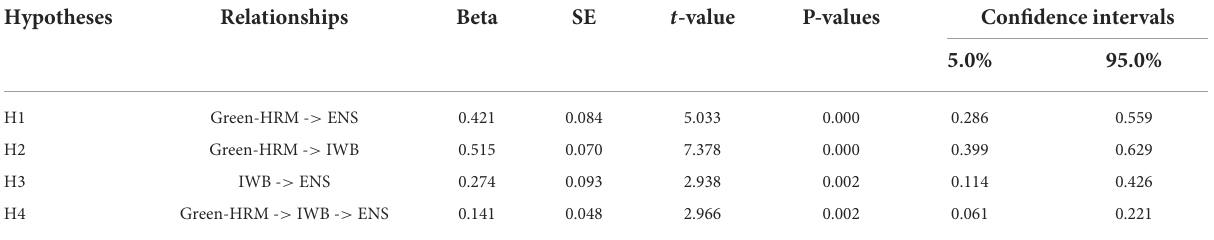
TABLE 3 Hypotheses